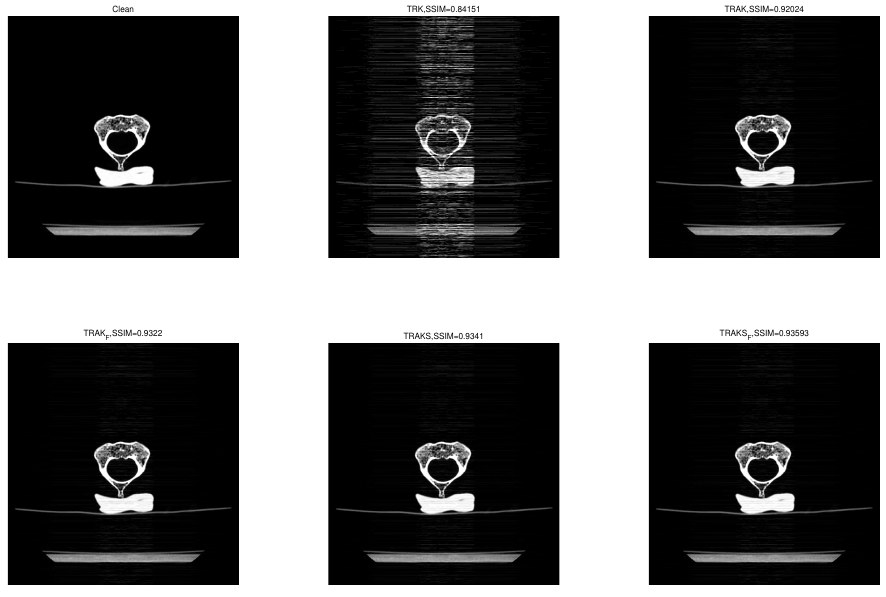
Figure 10. The 39 th slice of the clean image sequence and the images recovered by the TRK, TRAK, TRAK F algorithms. CPU TRK = 12.0177, CPU TRAK = 9.3976, CPU TRAK = 9.2294, CPU TRAKS F